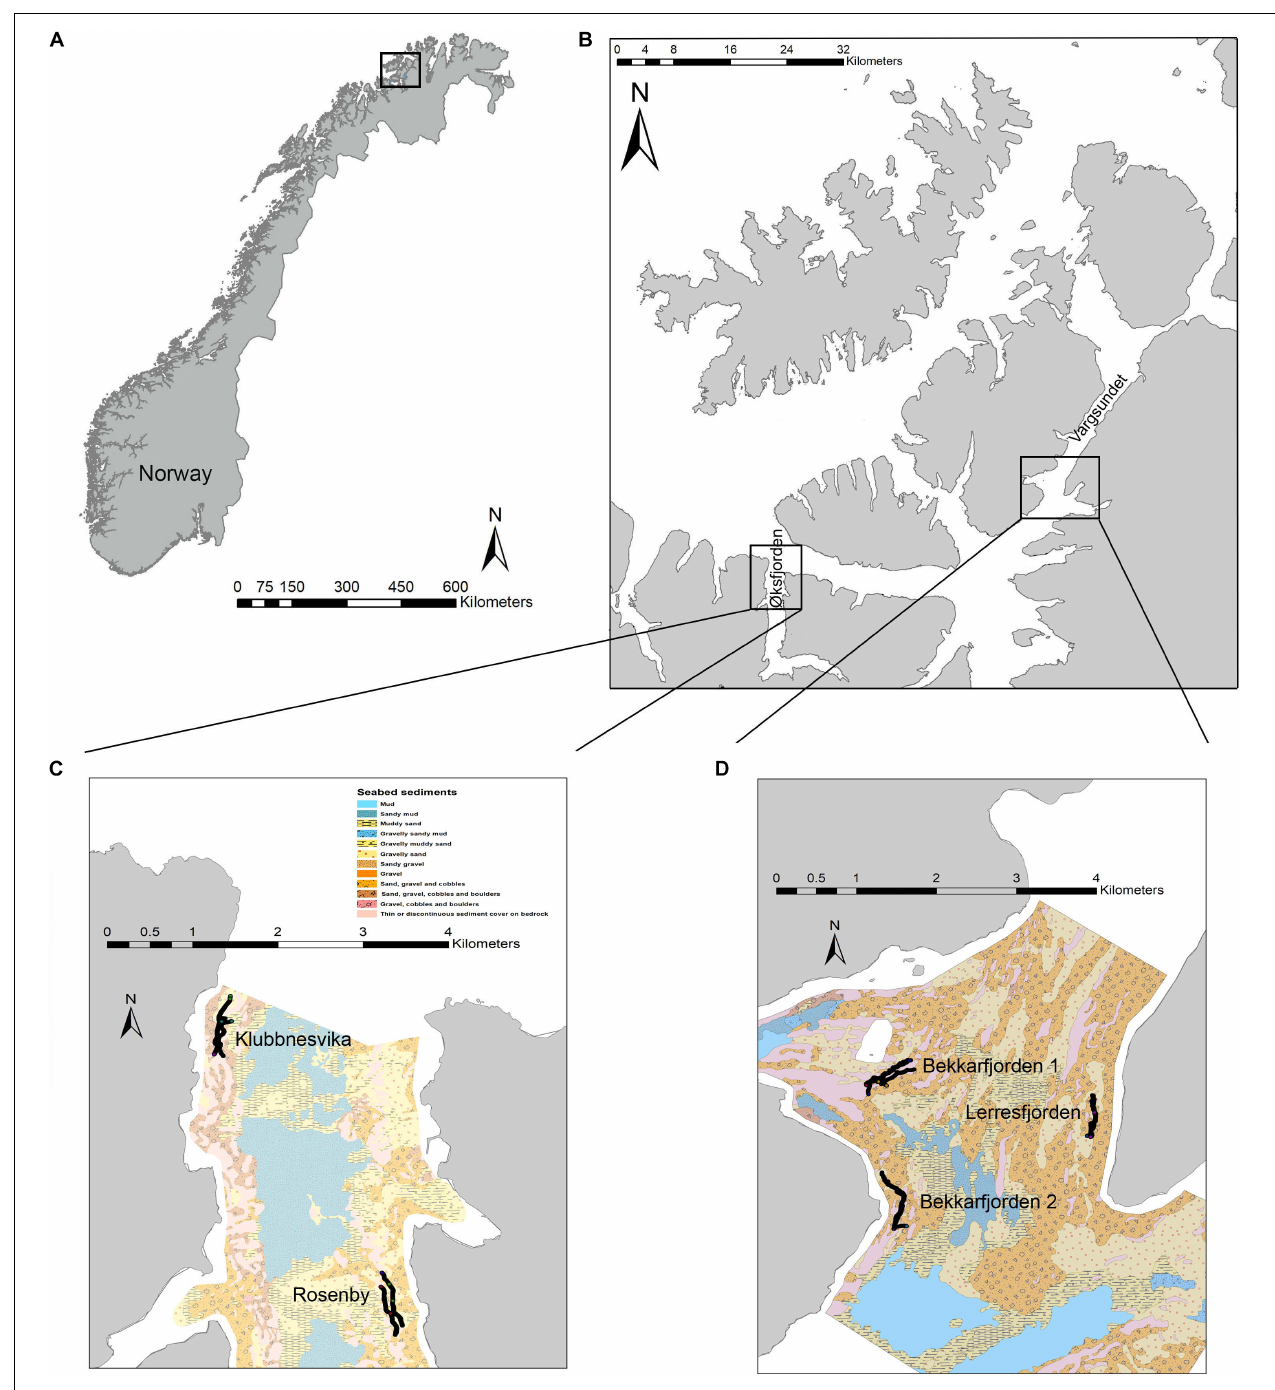
FIGURE 1 | The sampling sites; (A) on the north western coast of northern Norway, (B) in Øksfjorden and Vargsundet and the mixed-substrate seabed substrate characteristics of sampling sites in (C) Øksfjorden and (D) Vargsundet. Seabed substrate maps include the positions of the video transects.